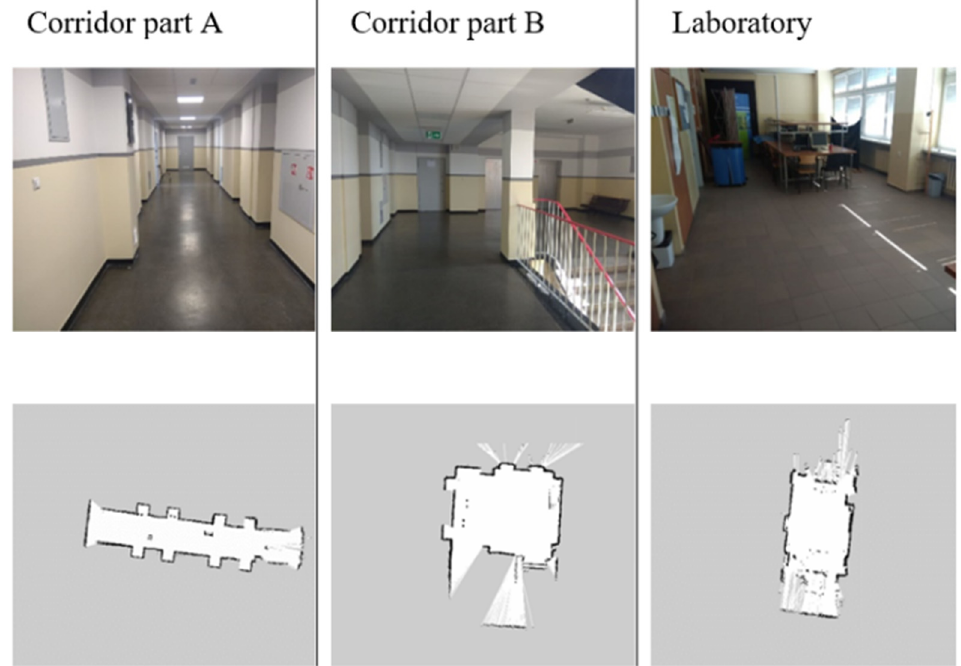
Figure 12. The test scenarios with the Lidar point map.